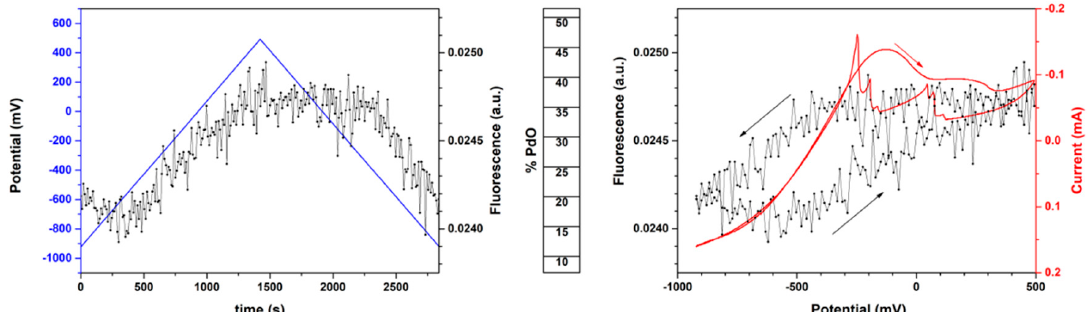
Figure 6. FEXRAV data obtained on the Pd / KOH / EtOH half-cell system at 24,370 eV. Potential scan (blue line) and Fluorescence signal (black line) versus time (Left Figure); Cyclic voltammetry (red line) and Fluorescence signal (black line) versus the applied potential (in the right Figure). Between the Figures, the scale indicating the molar fraction of Pd(II) evaluated according to the procedure described in the text.